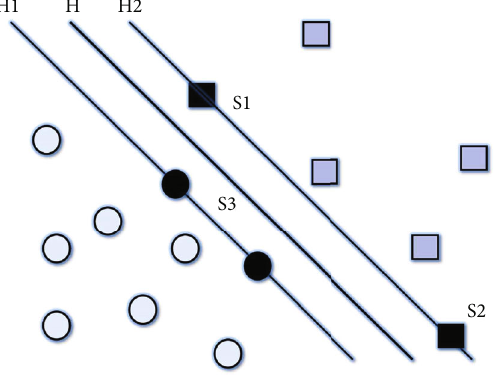
Figure 4: Optimal classi fi cation surface.